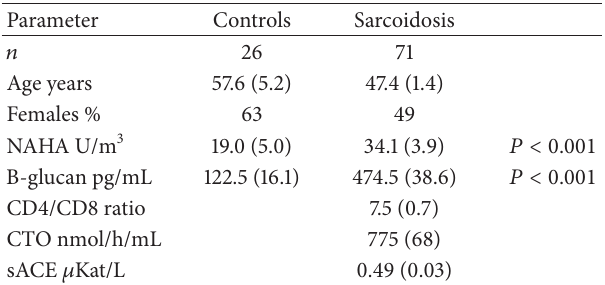
Table 1: Basic characteristics of subjects with sarcoidosis. Mean and (SEM).